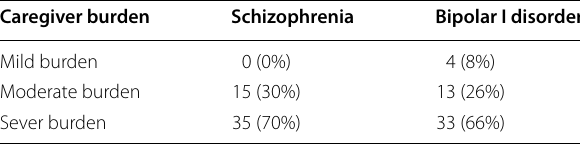
Table 1 Perceived caregiving burden in the caregivers